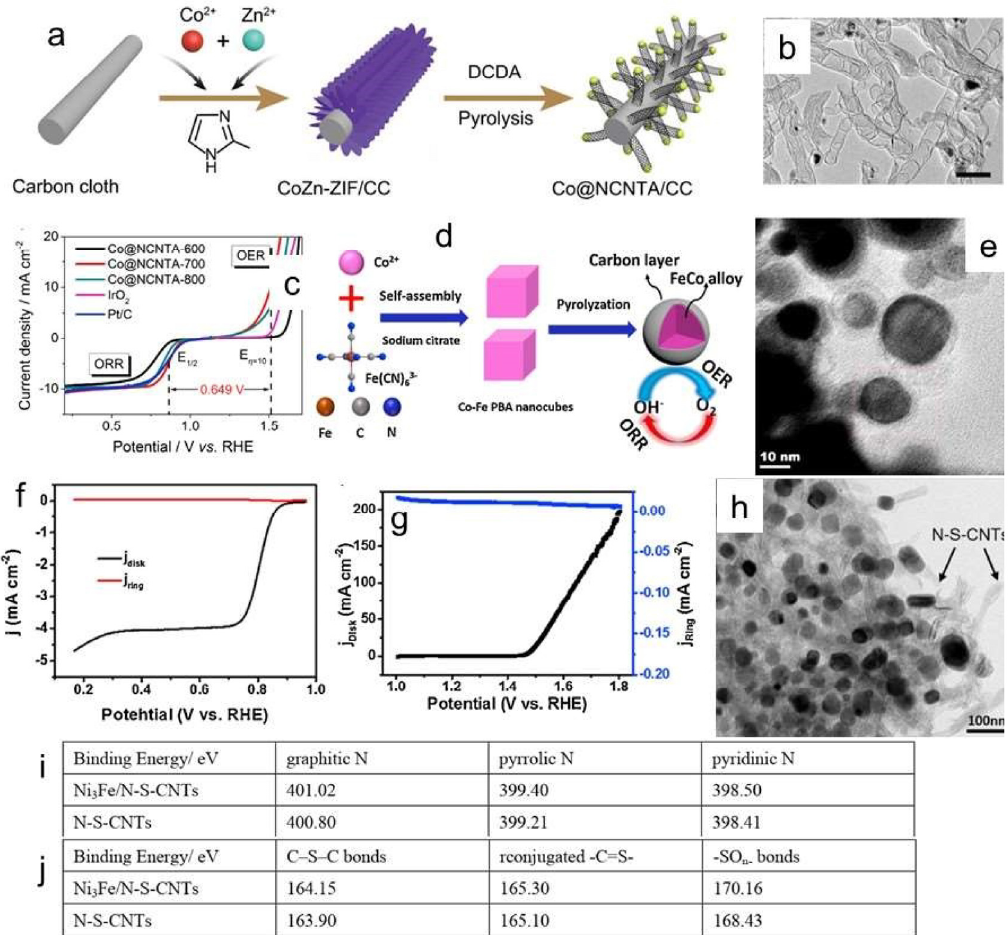
Figure 4. Preparation procedure and oxygen-related reaction performance of Co@NCNTA, FeCo@NC, and FeNi 3 @NC. ( a ) Synthesis process for Co@NCNTA. ( b ) Low-magnification TEM image. ( c ) Overall polarization curves of Co@NCNTA-600, Co@NCNTA-700, Co@NCNTA − 800, Pt/C, and IrO 2 in 0.1 M KOH solution. Overall electrocatalytic oxygen performance ( ∆ E = E j=10 − E 1/2 ) confirmed by half- wave potential for ORR and potential for OER at 10 mA cm − 2 . Reproduced from [62], copyright 2019, Wiley − VCH Verlag GmbH & Co. ( d ) Synthesis of FeCo@NC core − shell nanoparticles. ( e ) TEM image of FeCo@NC-750; ( f,g ) Polarization curves of disk and ring current density on an RRDE at the rotating speed of 1500 rpm of FeCo@NC-750. Reproduced from [75], copyright 2016, Elsevier. ( h ) TEM image of Ni 3 Fe/N − S − CNTs. ( i , j ) Statistics of bonding energy measured by XPS. Reproduced from [85], copyright 2018, Chemical Society of